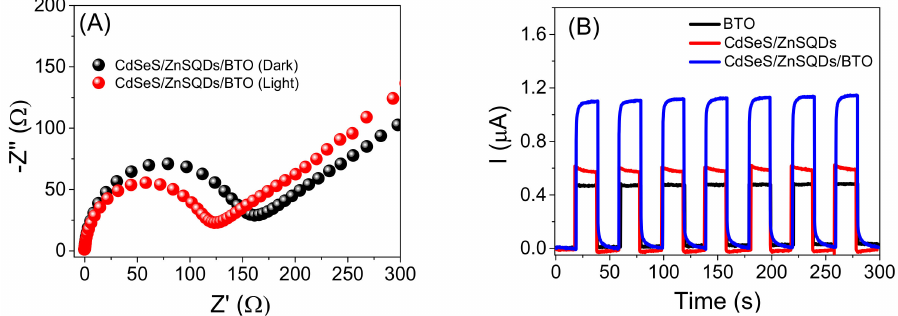
Figure 3. ( A ) EIS spectra of the FTO modified with CdSeS/ZnSQDs/BTO were obtained in 0.10 mol L − 1 of potassium chloride with 0.005 mol L − 1 of potassium ferricyanide in the pres- ence (red balls) and absence of visible LED light (black balls); ( B ) Photocurrent obtained for the CdSeS/ZnSQDs/BTO/FTO (blue line), CdSeS/ZnSQDs/FTO (red line), and BTO/FTO (black line) in 0.10 mol L − 1 of PBS, pH 7.4, containing 0.20 mol L − 1 of VC, under applied potential of 0 V vs. Ag/AgCl (st.